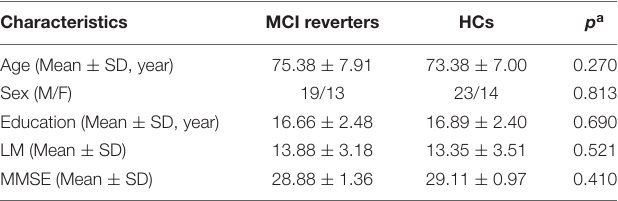
TABLE 1 | Demographic and neuropsychological characteristics of the included subjects. Characteristics